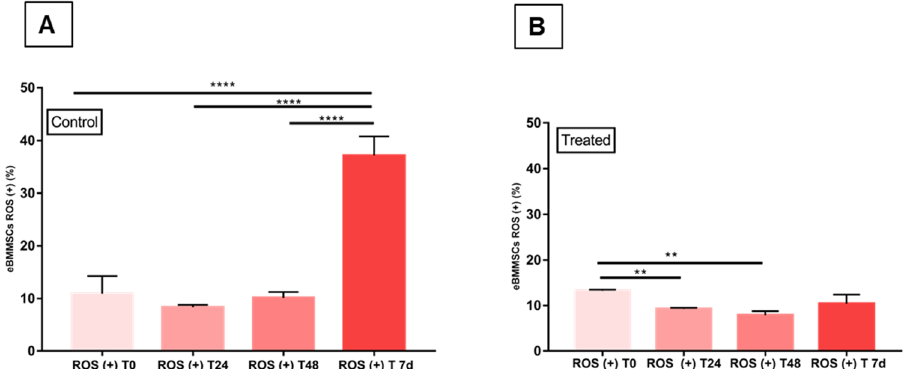
Fig. 9 Comparisons of eBMMSC ROS ( + ) at T 0 h, T 24 h, T 48 h and T 7 days. A Comparisons of eBMMSC ROS ( + ) between the time points of the control group. **** indicates P < 0.0001. B Comparisons of eBMMSC ROS ( + ) between the treatment groups. ** indicates P < 0.009 e P < 0.0015